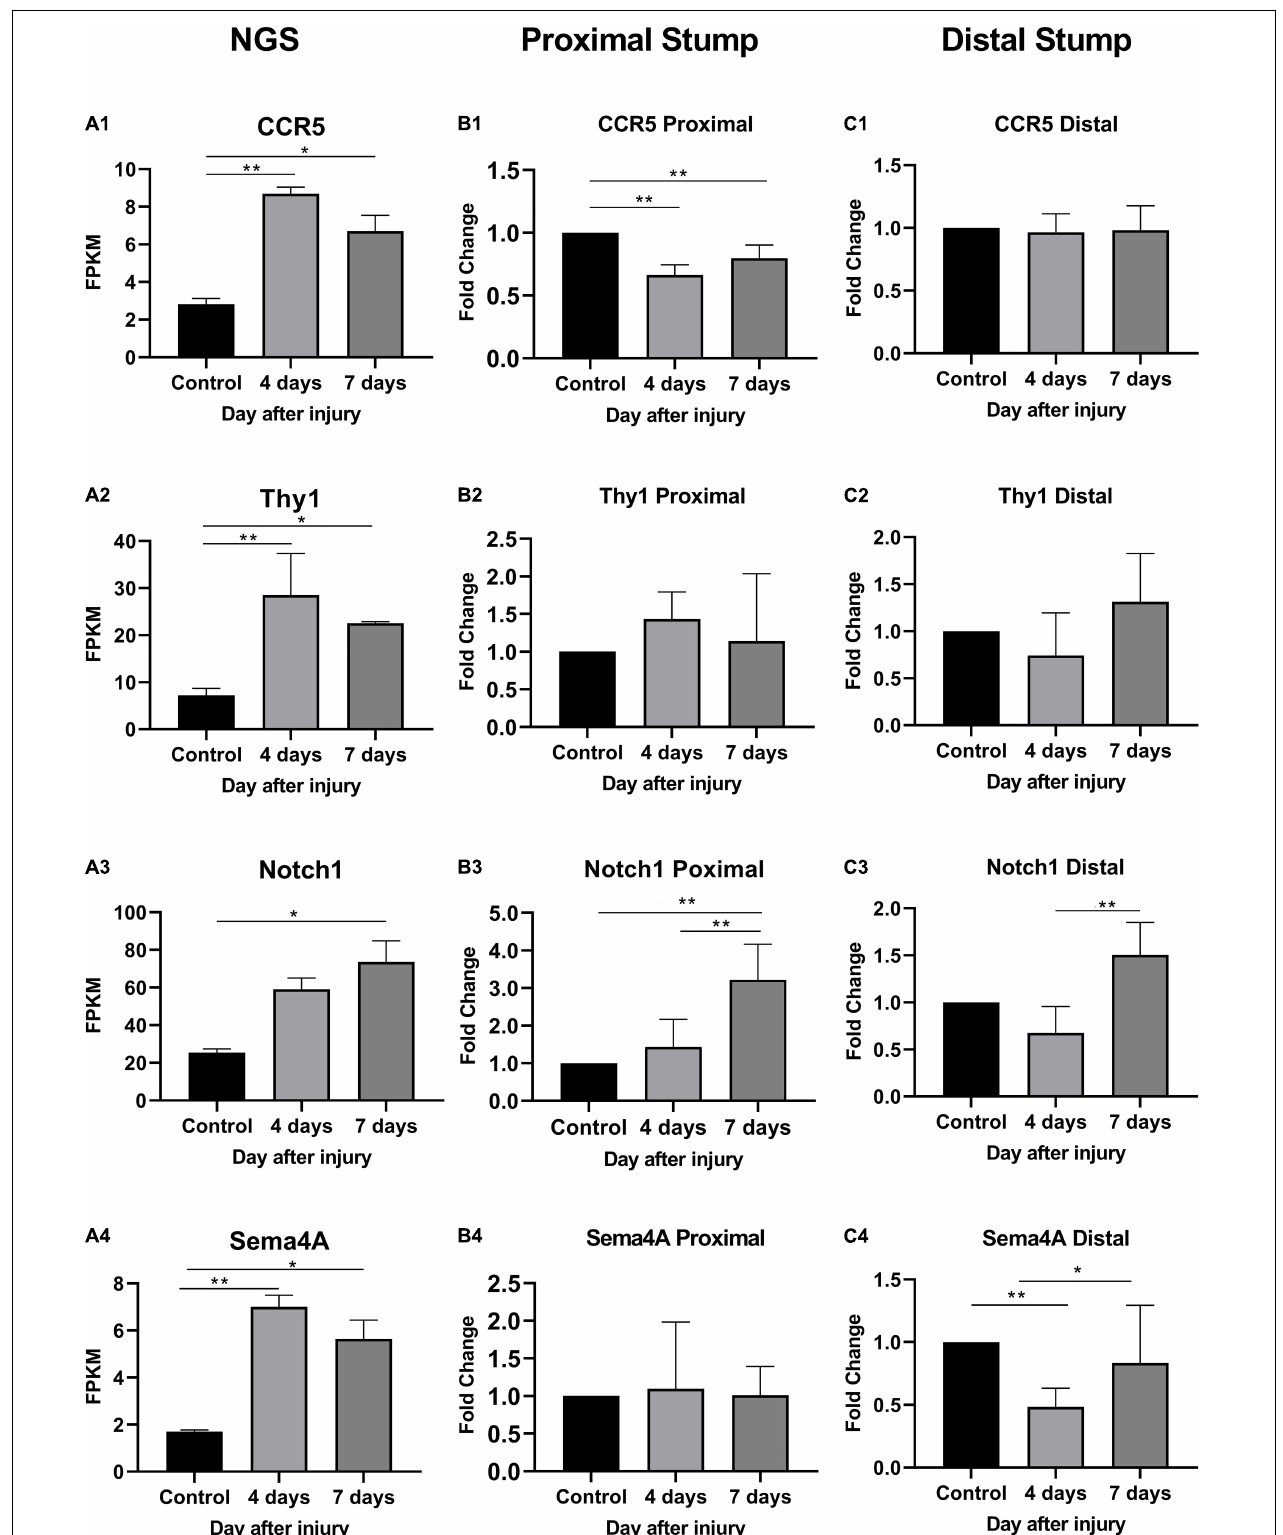
FIGURE 6 | Expression levels of DEmRNAs common to angiogenesis, axonal regeneration and immune response. (A) NGS results; (B) qRT-PCR expression of genes in proximal part after injury; (C) qRT-PCR expression of genes in distal part after injury. (A1–C1) CCR5 expression; (A2–C2) Thy1 expression; (A3–C3) Notch1 expression; (A4–C4) Sema4a expression. * denotes P < 0.05 compared with the control group, and ** denotes P < 0.01 compared with the control group.